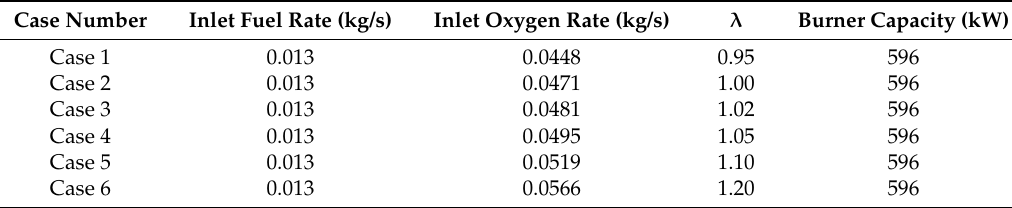
Table 3. Inlet boundary condition for the different cases in this study.